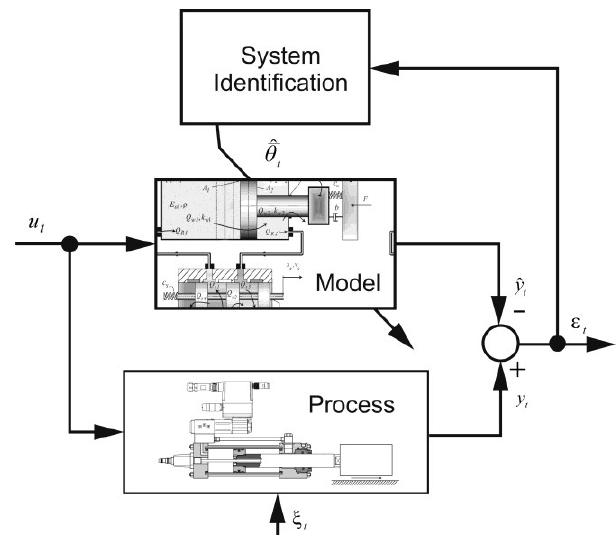
Fig. 2. Block diagram of adjusting the object model: u t control  signal, y t object output signal, y output signal of the object t model,  ˆ estimate vector of the object model parameters, object  model error, t t 